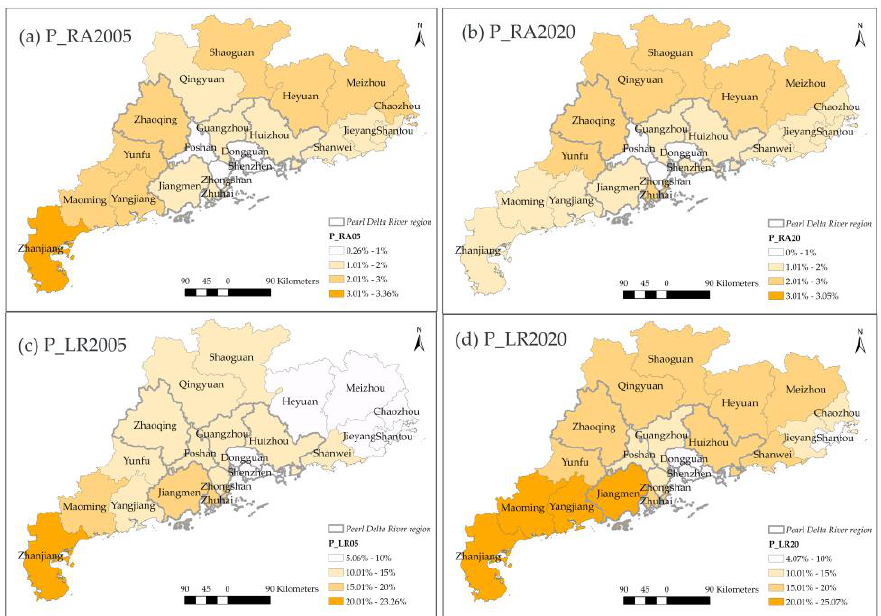
Figure 9. The spatial distribution of P_RA and P_LR in 2005,2020.